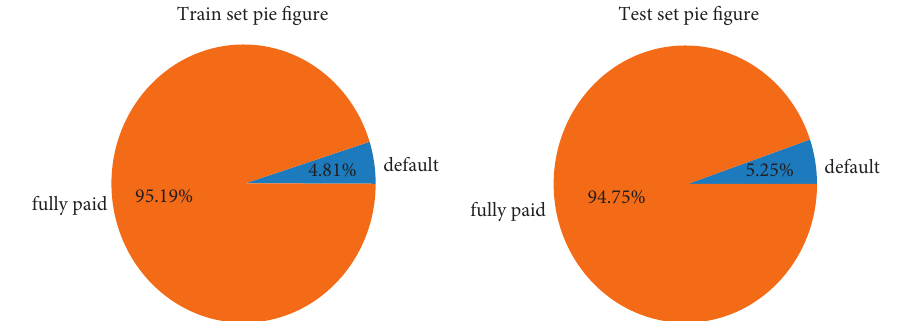
Figure 4: Total revenue comparison of cloud service providers.